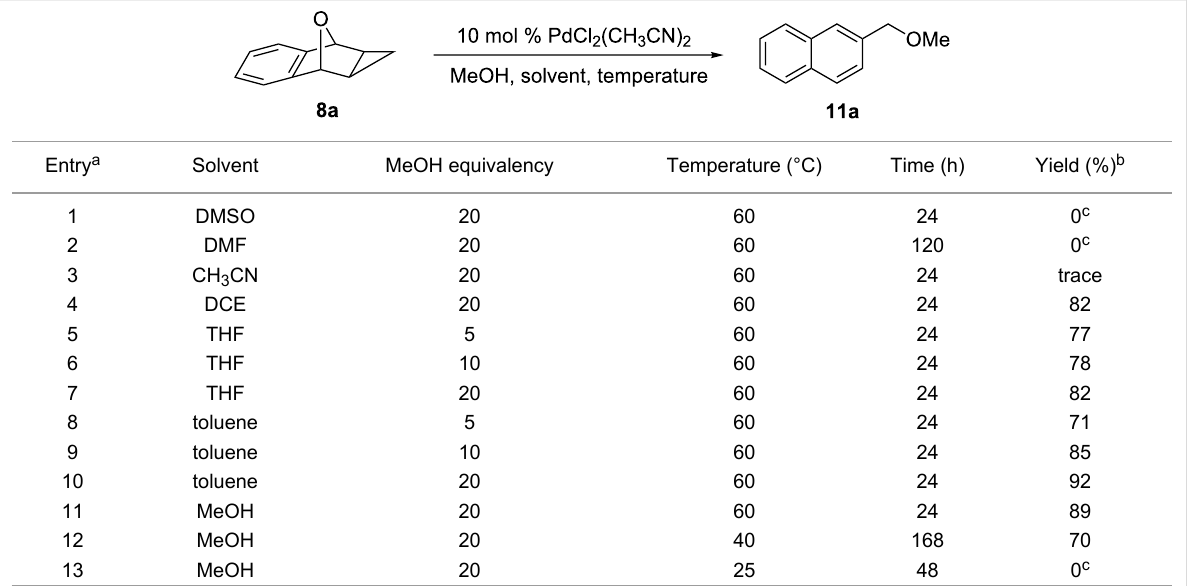
Table 2: Effects of solvent, nucleophile equivalency, and temperature on the ring-opening reactions of 8a with alcohols.